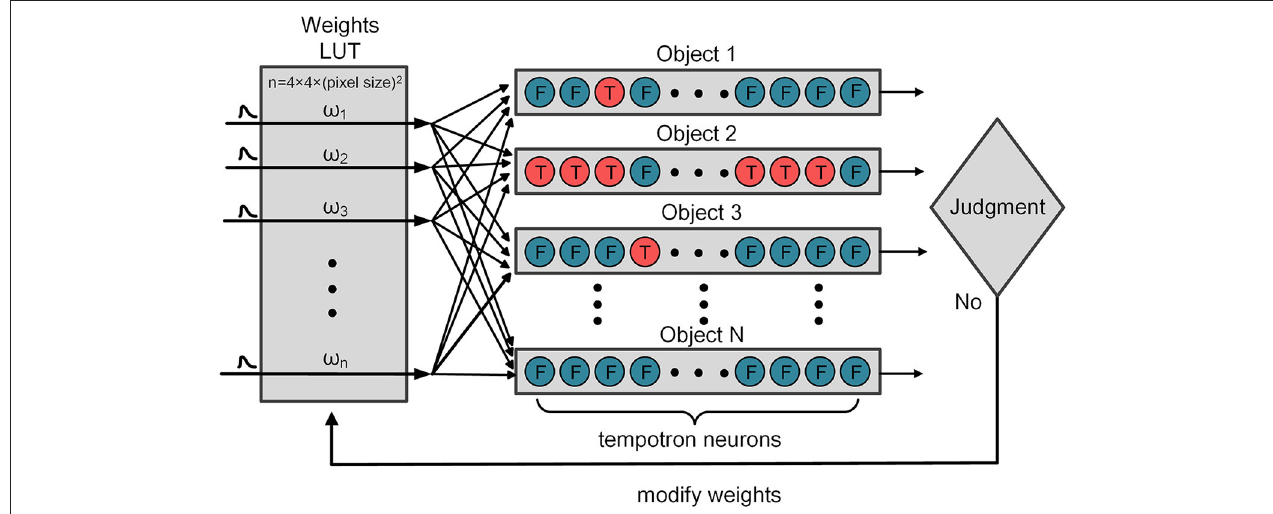
FIGURE 3 | The procedure of weights